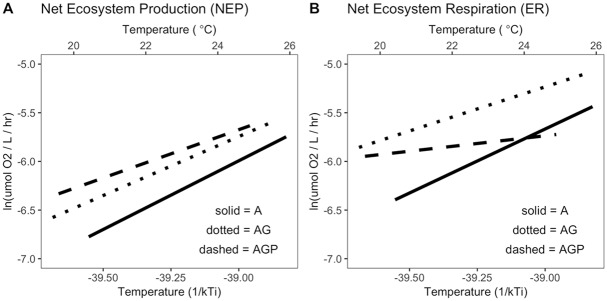
The effect of mean ecosystem temperature on (A) NEP and (B) net ER for three community types that varied in their trophic interactions: (i) algae-only (A), (ii) algae + grazers (AG), and (iii) algae + grazers + notonectid predators (AGP).Black lines indicate the among-ecosystem effects of temperature, modeled by Eq 5 using hierarchical regressions fit to among-ecosystem variation in temperature, after taking into account within-group variation temperature effects (light lines) (Tables 1, 6 and 7). Temperature dependences within and among tanks were estimated by best model or best model set (Tables 1, 6 and 7, Methods: Statistical analyses). Temperature in Celsius is shown for comparison only; models were fit to inverse temperature. All measured data points to which models were fitted are shown in Fig 6. Temperatures within tanks declined over time (S2 Fig). Data for these figures may be found at https://doi.org/10.5281/zenodo.2652579 in GarzkeAllwks.csv. A, algae only; AG, algae and grazers; AGP, algae, grazers, and predators; ER, ecosystem respiration; NEP, net ecosystem production.